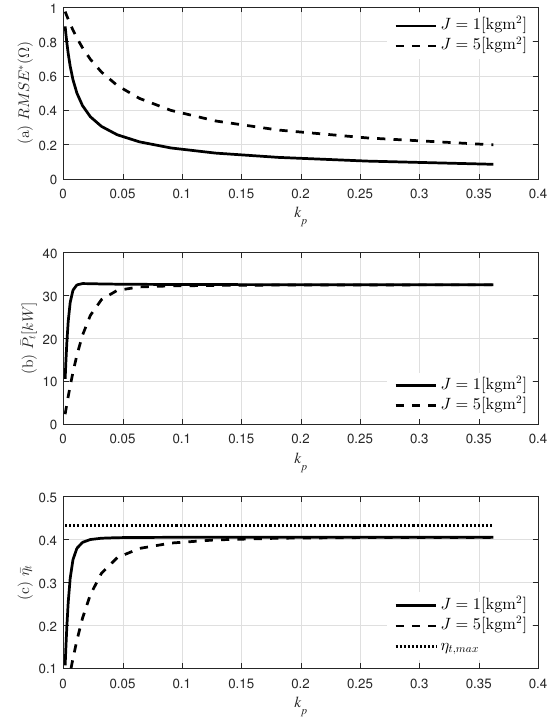
Figure 10. Results of the CAV controller with various k p under an equivalent irregular wave condition when Ω d = 400 rad/s: ( a ) relative root mean squared error of Ω ; ( b ) average power extraction from the turbine; ( c ) average turbine efficiency and its maximum